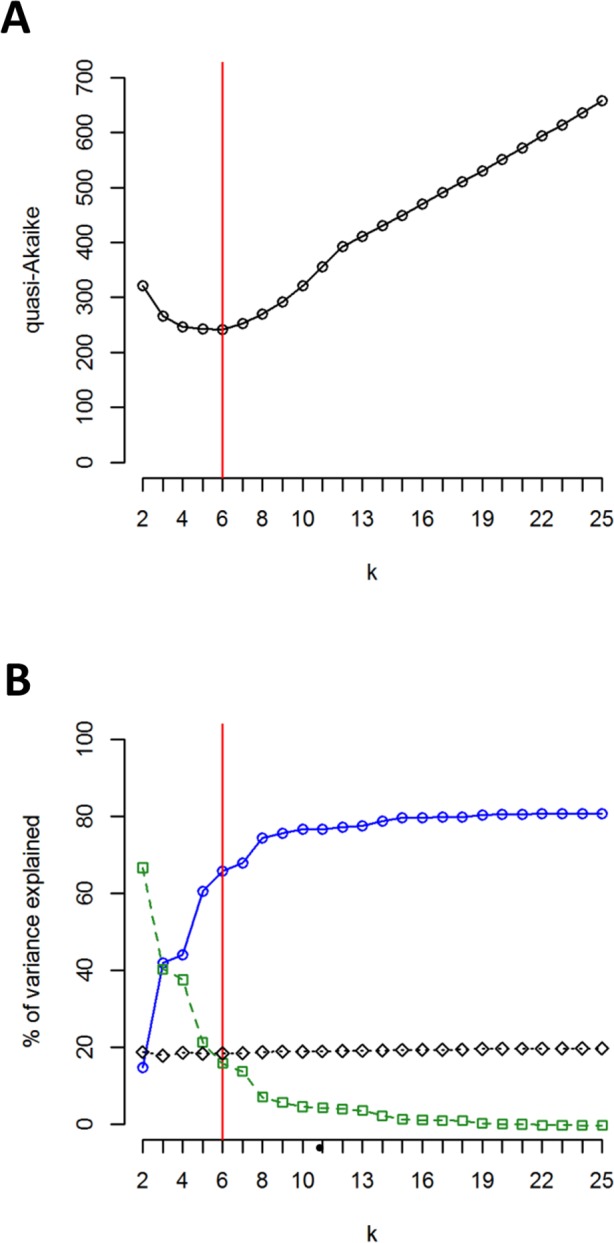
Results of SKMC and AMOVA.(A) Value of the quasi-Akaike information criterion as a function of k (number of groups identified by SKMC analysis). Statistically optimal solution (having the lowest value of the quasi-Akaike criterion) is marked with a red line. (B) Percent of genetic variance among groups of populations identified by SKMC (blue), among populations within groups (green) and within populations (black) calculated by AMOVA. Statistically optimal solution of SKMC is marked with a red line.